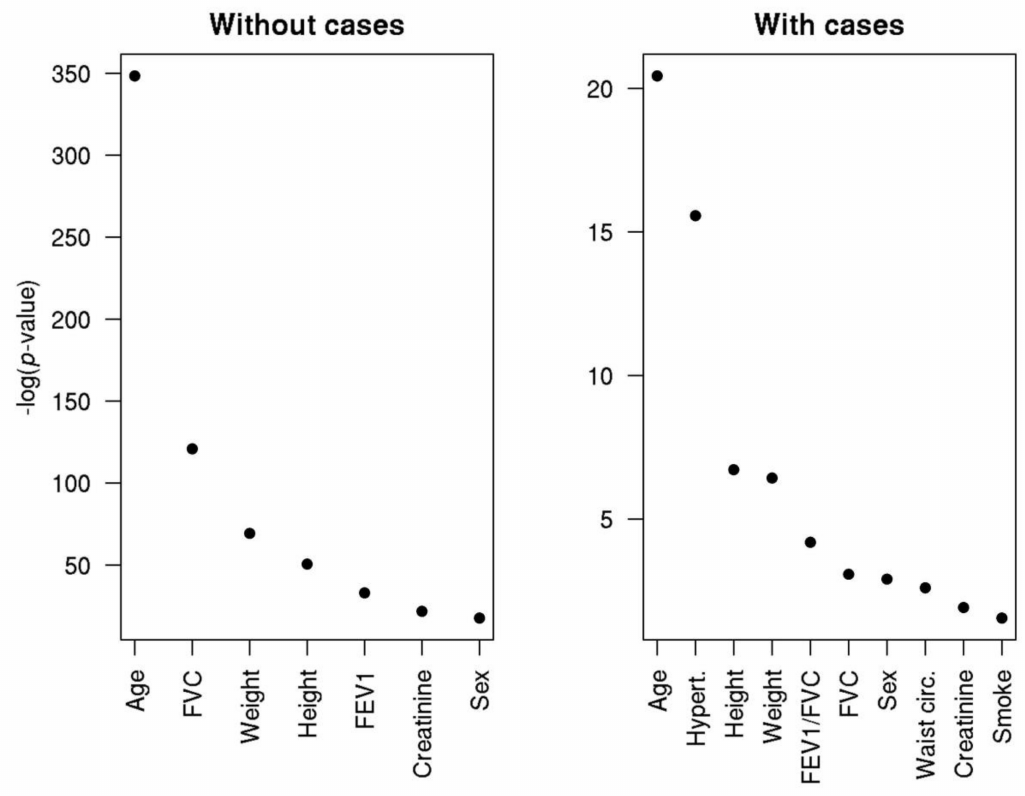
Figure 1. Best predictor variables for aortic diameter. Y -axis reports the estimated probability that each variable improves the accuracy of the predictive model.